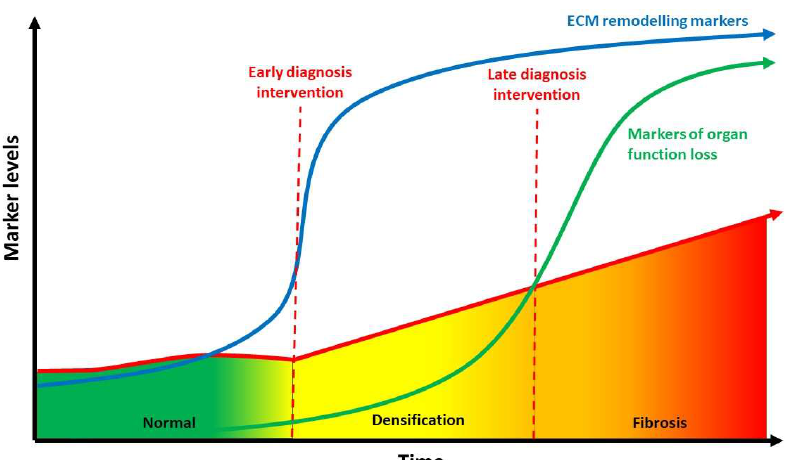
Figure 3. Relationship between hyaluronan concentration (indirect evaluated through ECM), densification and fibrosis over time. Biomarkers of ECM remodeling may identify molecular processes occurring in the early phases of densification, giving the opportunity for early intervention when the disease is still reversible before fibrosis sets in. ECM: extracellular matrix (Modified from [102]).